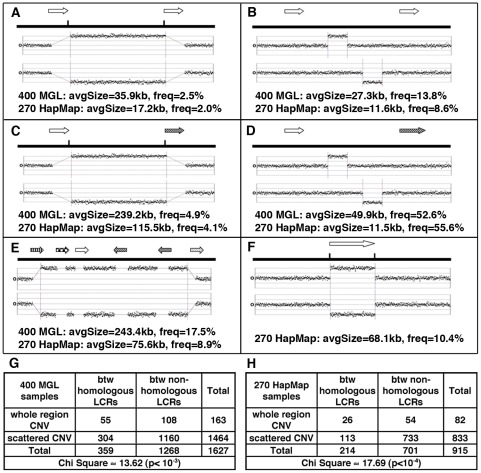
Major patterns of CNVs in relation to LCRs (arrows with same texture indicates paralogous LCRs).(A) CNVs involving whole regions between DP-LCRs. (B) Scattered CNVs (CNVs covering <40% of the distance between LCRs) between DP-LCRs. (C) CNVs involving whole regions between non-paralogous LCRs. (D) Scattered CNVs between non-paralogous LCRs. (E) Complex patterns of CNVs extending over various LCR groups and intervening regions. (F) CNVs overlapping LCRs. (G–H) Contingency tables summarizing the counts of CNVs observed between LCRs, corresponding to A, B, C and D. The CNVs between paralogous LCRs tend to involve the whole region (as illustrated in A, corresponding to counts in top left cells in G and H), a signature of NAHR involving paralogous LCRs.